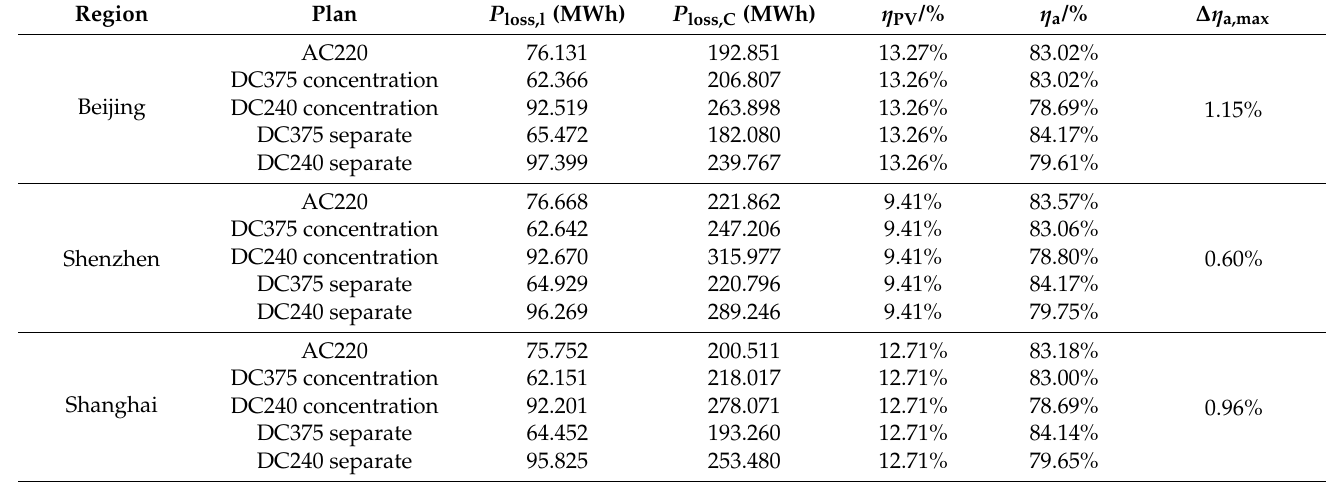
Table A1. Comparison of energy efficiency of office buildings with different topologies in three regions. Region